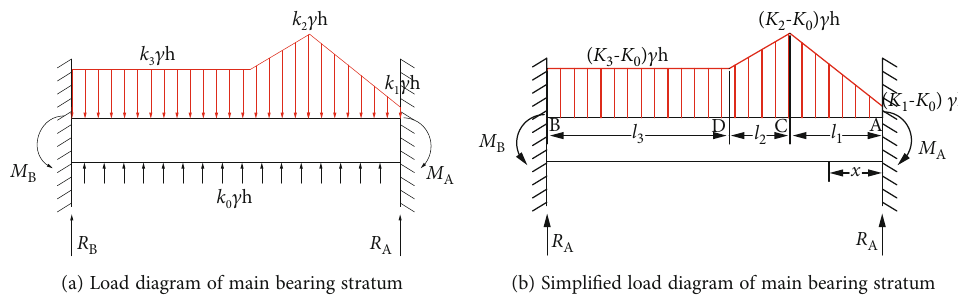
(b) Simpli fi ed load diagram of main bearing stratum Figure 8: Stress model of main bearing stratum under coal